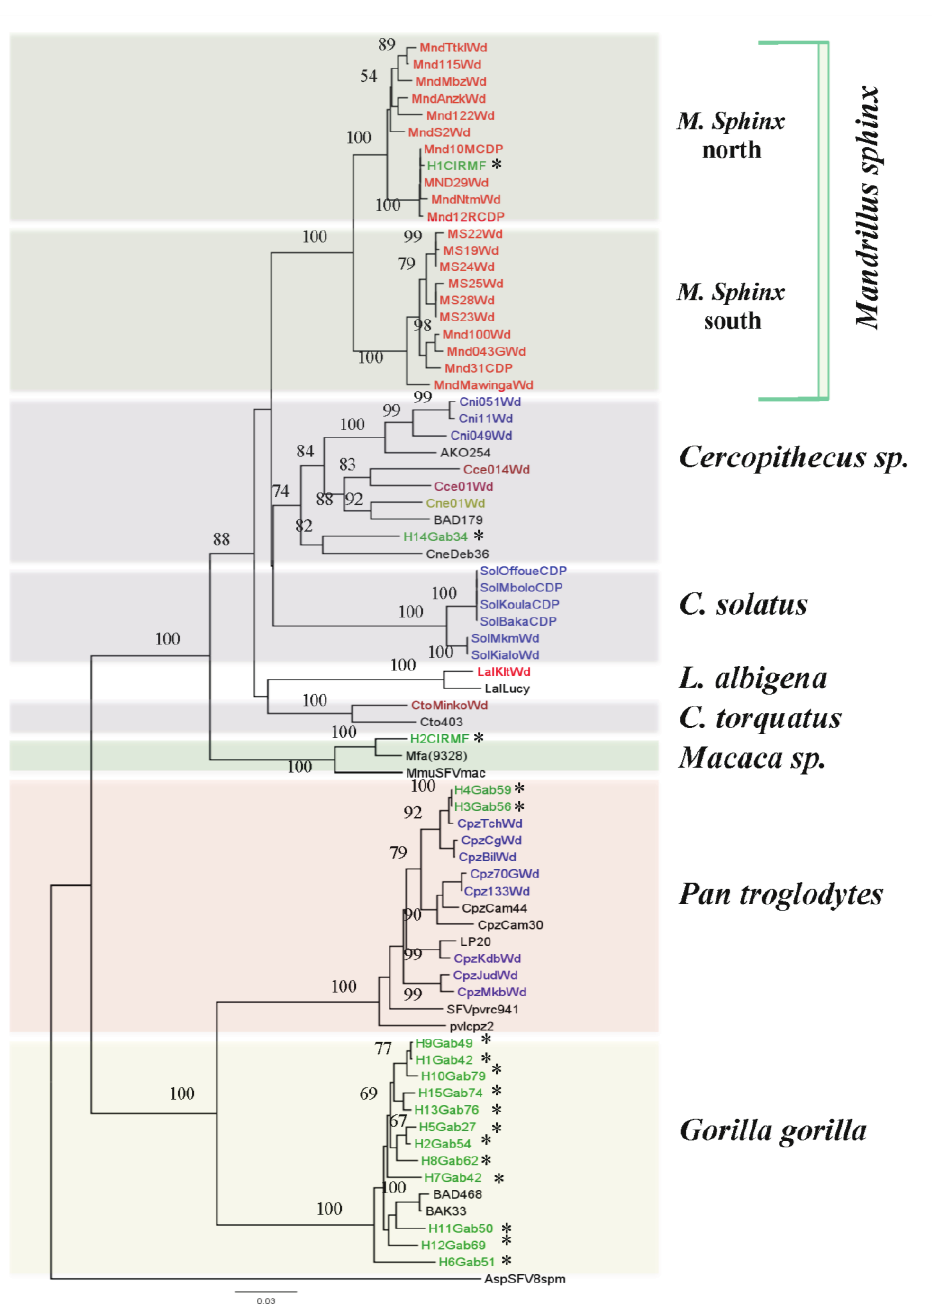
Figure 4. Phylogenetic relations of integrase sequences (425 bp) obtained from semi-free-ranging mandrills, wild-born mandrills, wild-born monkeys and apes as well as from SFV-infected humans in Gabon. SFV sequences were aligned with ClustalW (1.81) and edited with Bioedit. Phylogenetic analyses were performed by the Bayesian Markov chain Monte Carlo method implemented in Mr Bayes 3.1 and the Rtrev model. Sequence Asp8SFVsp (from a spider monkey) was included as an out group. Values above the branches are bootstrap values. Non-human primates are indicated by the name of the species (e.g., Mnd, for mandrill), the number of the sample (e.g., 122), followed by Wd (wild) for the origin. (*) indicate SFV sequences obtained from humans, who are also indicated by H, an order number, Gab (for Gabon) and a